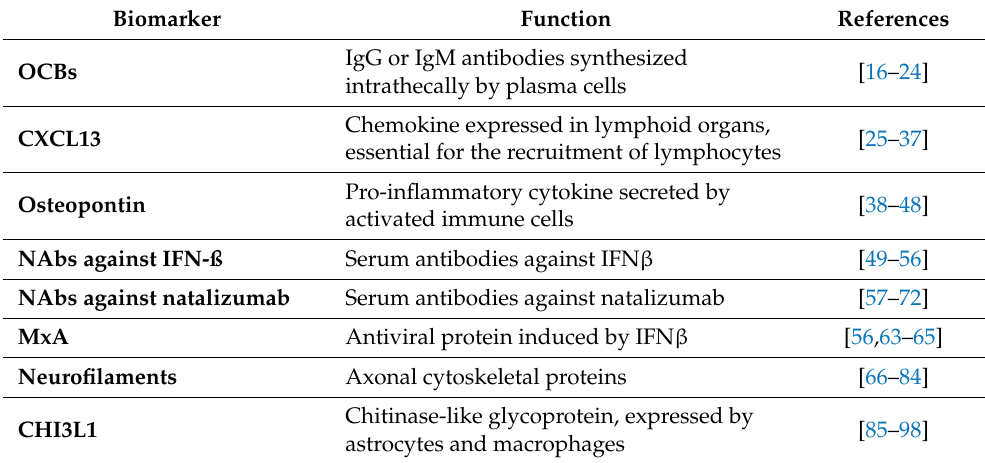
Table 2. Validated and promising treatment-response biomarkers and their